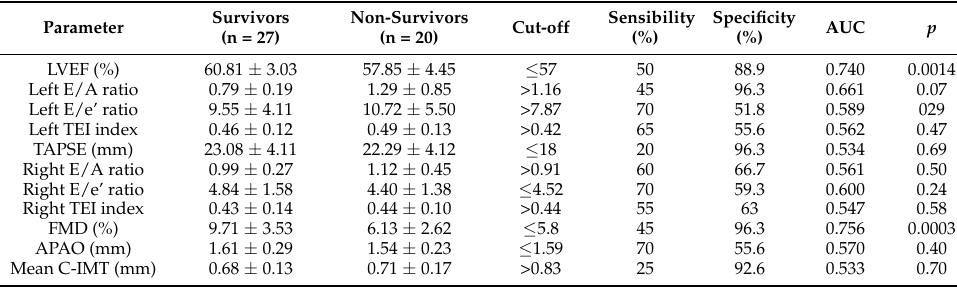
Table 3. Echocardiographic and vascular predictors of all-cause mortality.